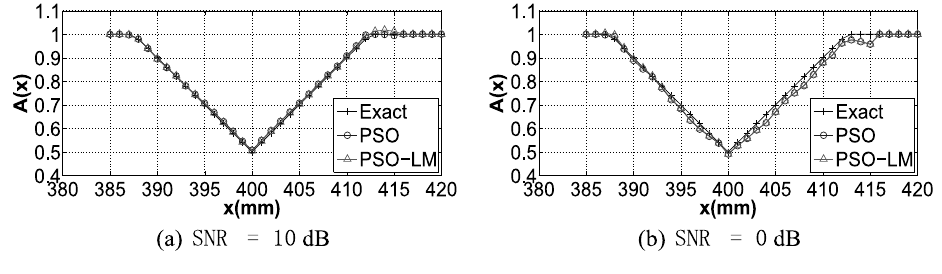
Fig. 12. Damage identi fi cation with two levels of SNR, Case 2 (Part